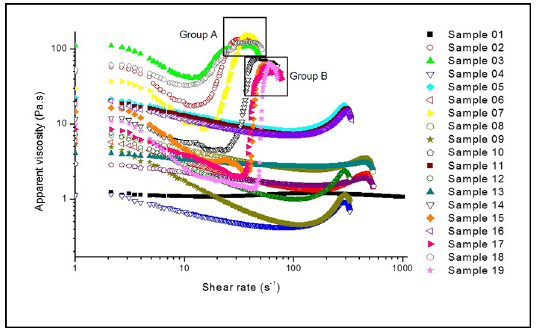
Figure 8. Apparent viscosity versus shear rate for silica-PEG 400